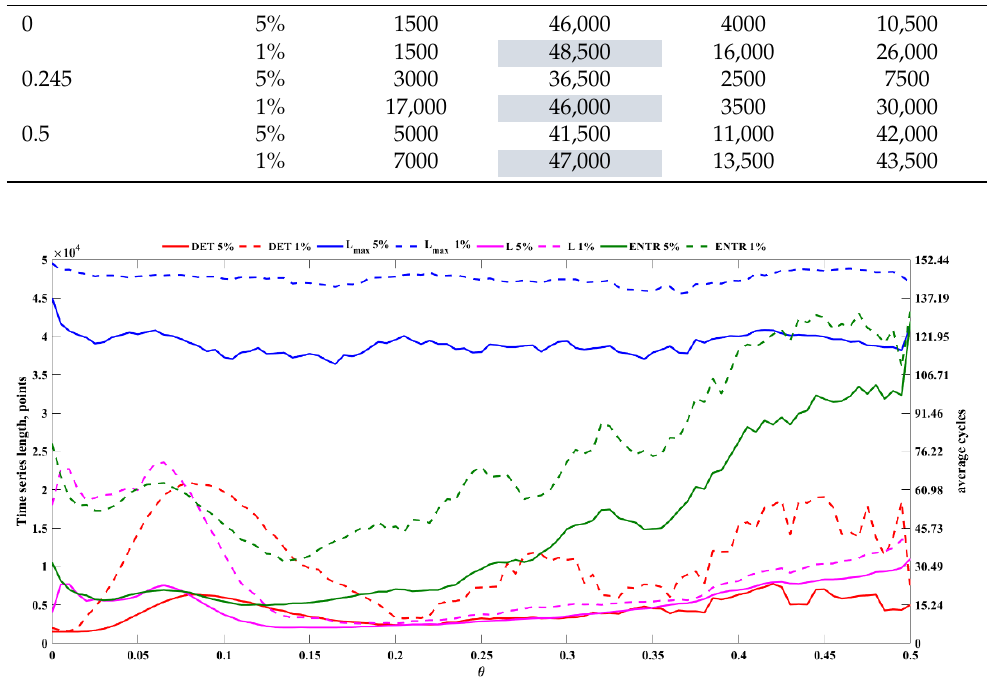
Figure 6. Length of the Rössler time series (left: in points, right: in average cycles) as a function of the noise level corresponding to a relative error equal to 5% (solid line) and 1% (dashed line) in the estimation of the determinism (red), maximal diagonal line length (blue), average diagonal line length (magenta), and entropy (green). Table 1. Values of determinism, maximal diagonal line length, average diagonal line length, and entropy obtained for long Rössler’s x time series for three different noise levels.